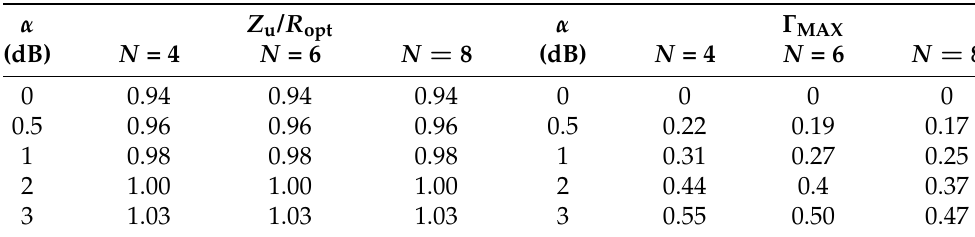
Table 1. Power contours equivalent mismatch settings, for a few cases of knee parameter N and contour level α .